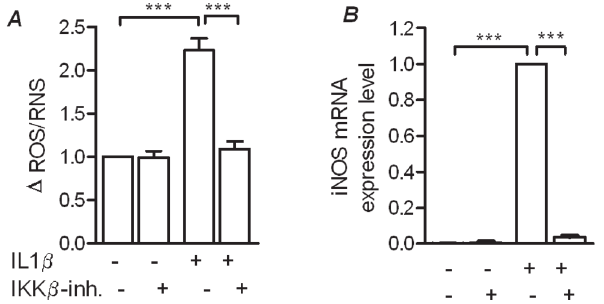
Figure 3. Prevention of IL-1 b mediated ROS in newborn rat islets of Langerhans by an IKK b -inhibitor correlates with transcription of iNOS. A : In newborn rat islets ROS was measured after 24 hours incubation in the presence or absence of IL-1 b and the IKK b -inhibitor. B : iNOS mRNA expression was quantified using RT-PCR after the islets had been incubation for 24 hours in the presence and absence of IL-1 b and the IKK b -inhibitor. All data are shown as the mean 6 S.E.M. (*p , 0,05; **p , 0,01; ***p , 0,001).